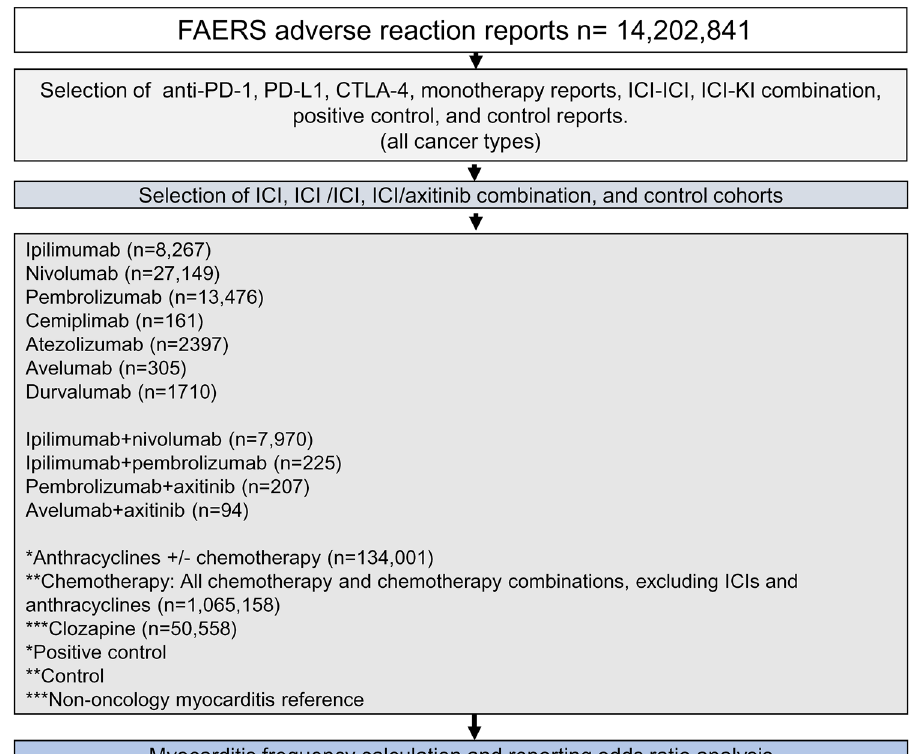
Figure 1. Selection of initial cohorts for ICI monotherapy, anti-PD-1 + CTLA-4, ICI + KI, positive control, and control